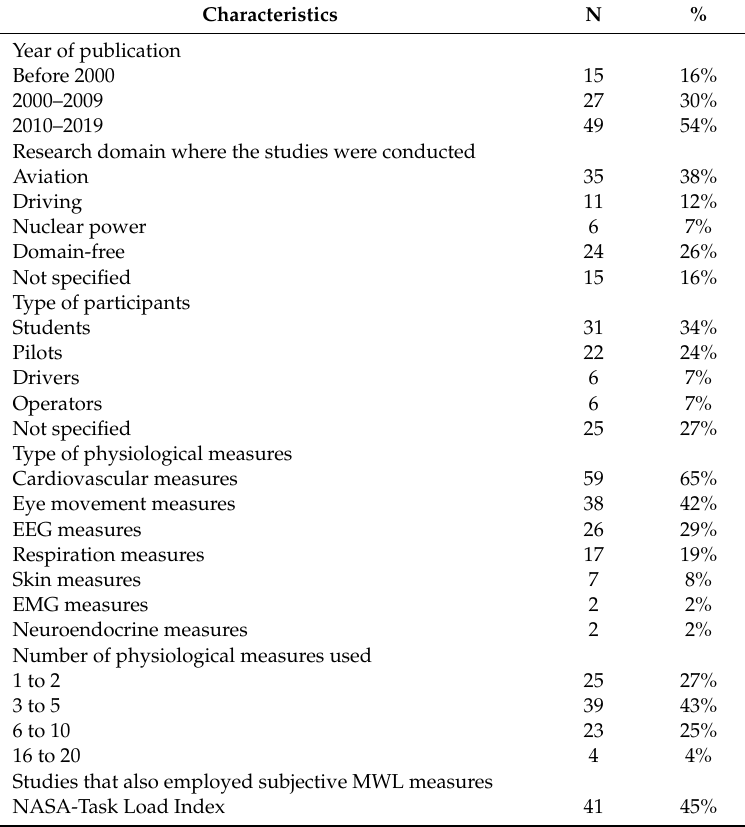
Figure 1. Study search and selection procedures. Table 2. Characteristics of the 91 studies